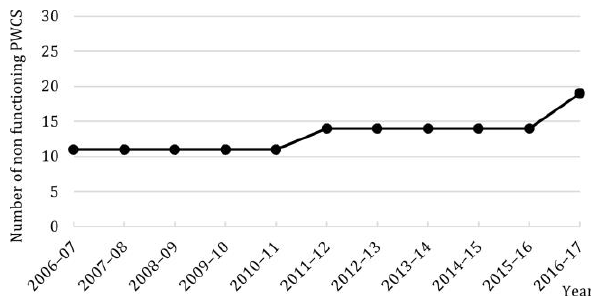
Fig. 8. Number of non functioning PWCS (Chinsurah zone) (Source: Handloom Development Office, Chinsurah, 2018)